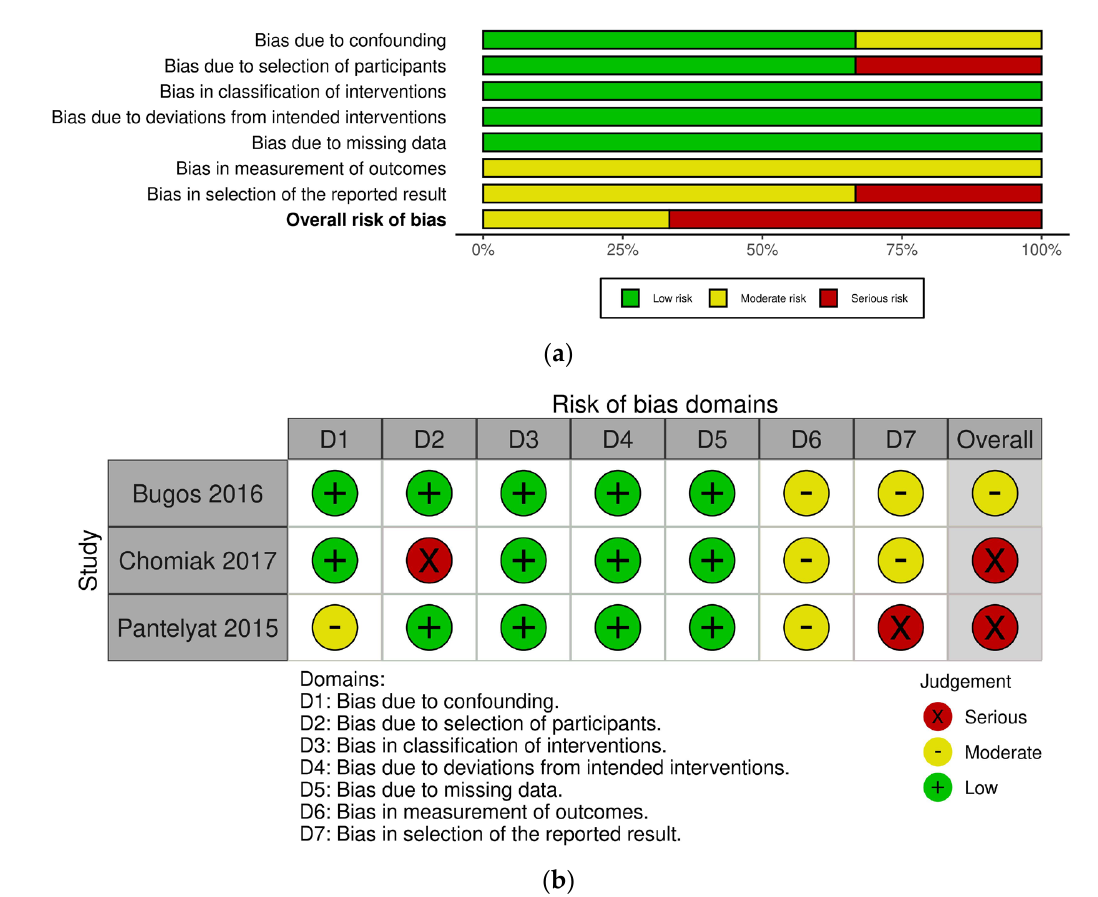
Figure 3. Risk-of-bias graphs for the controlled clinical trial (CCT) studies. ( a ) Risk of bias as a percentage and ( b ) risk-of-bias summary [28,29,37].